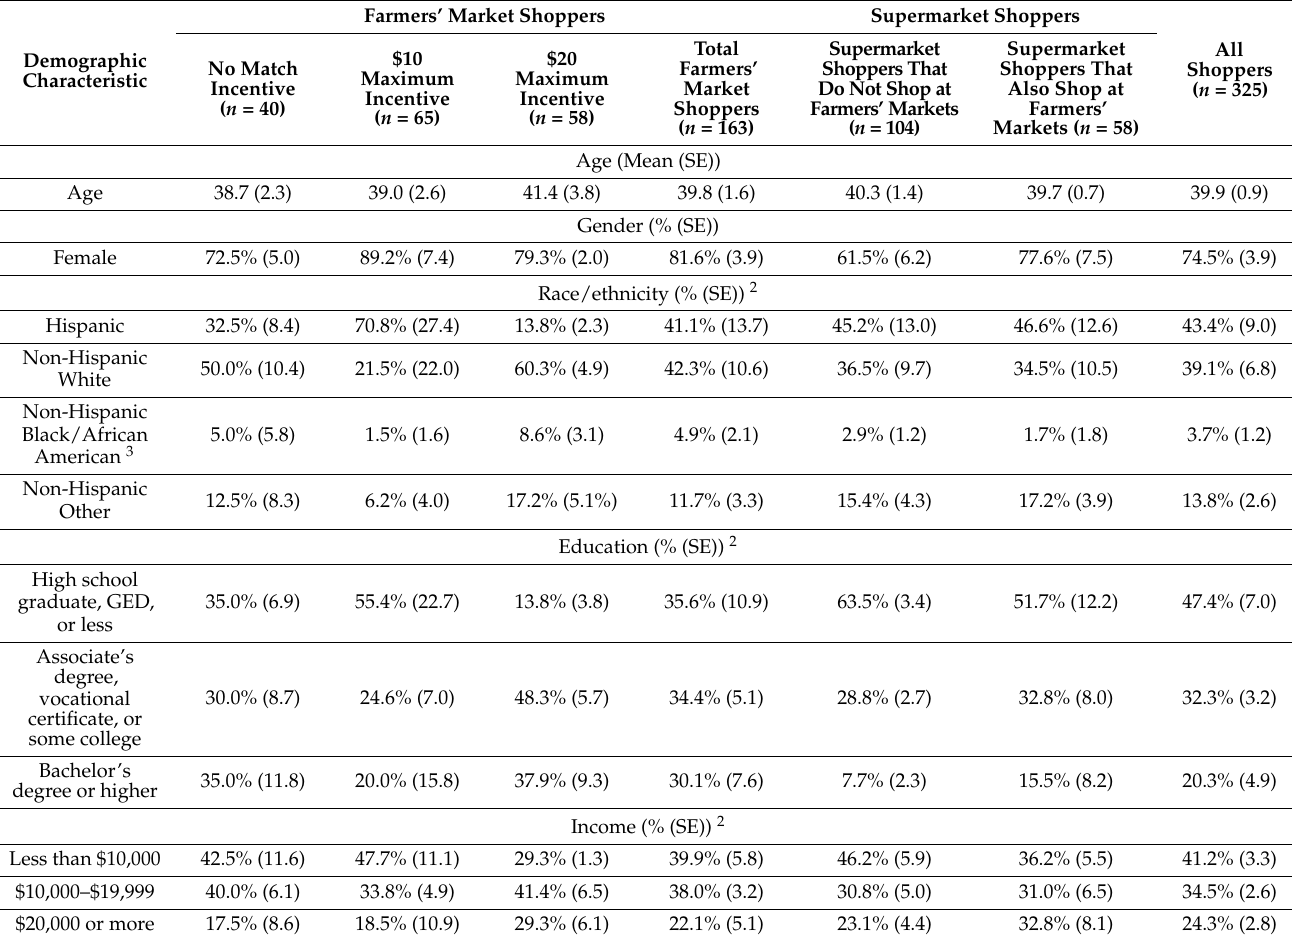
Table 1. Demographic characteristics of participants in the California Nutrition Incentive Program evaluation study by market type 1